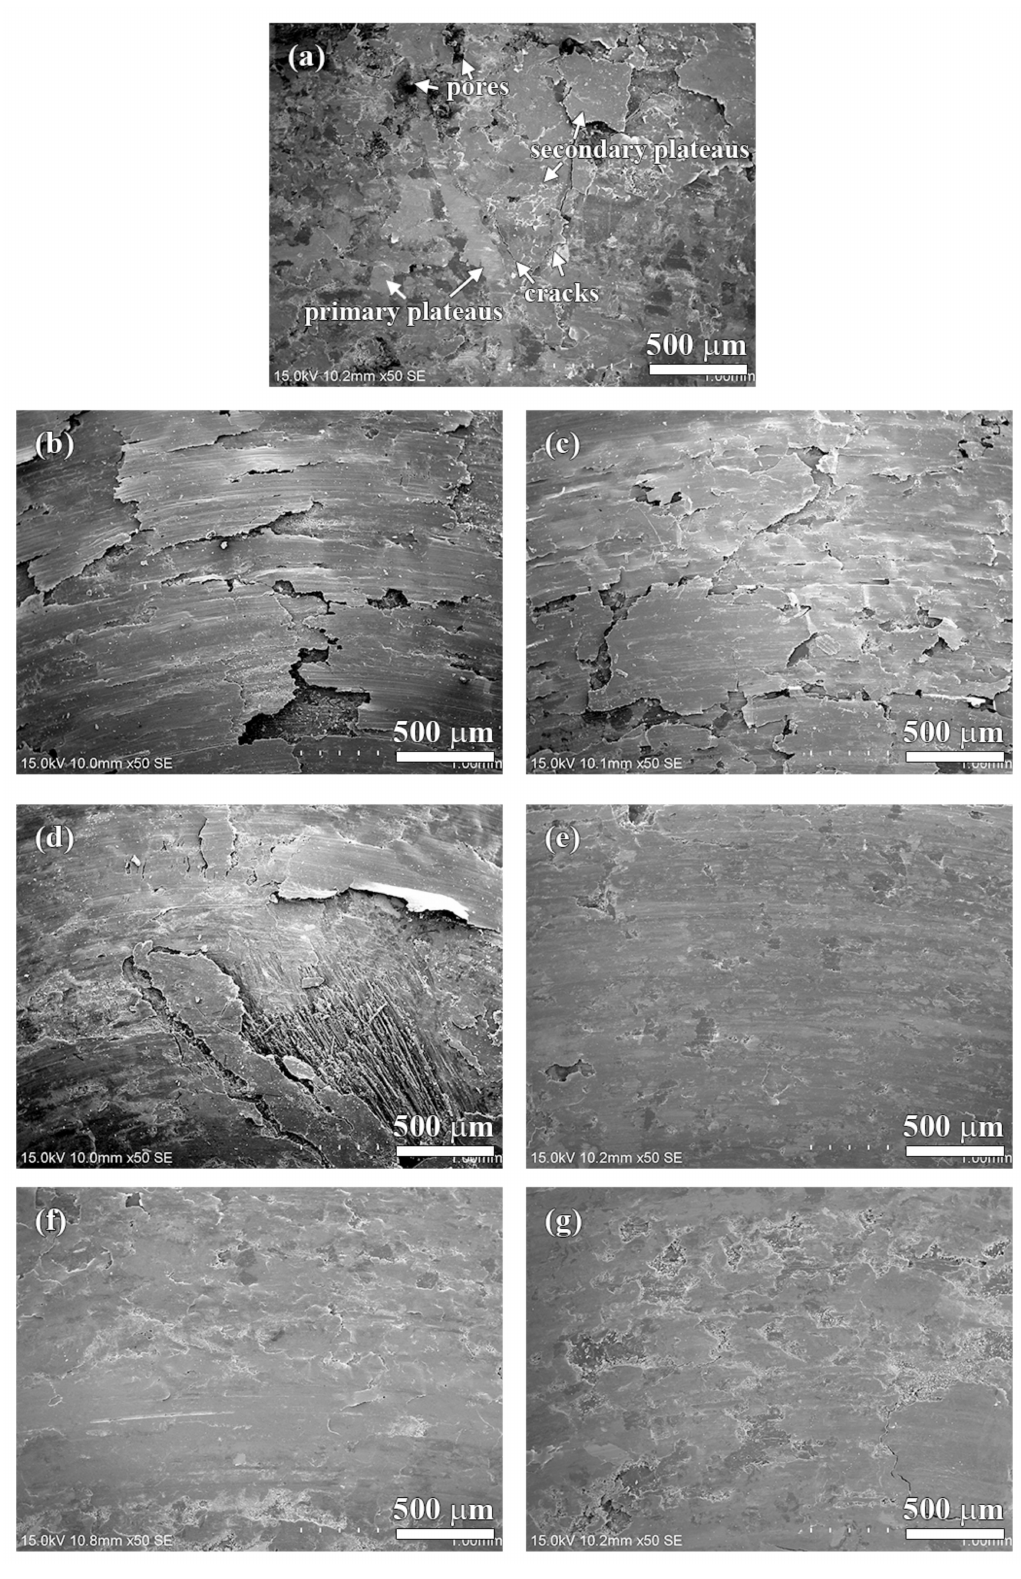
Figure 9. General worn surfaces of specimens: ( a ) NAO, ( b ) Coke, ( c ) CB, ( d ) CF, ( e ) AG, ( f ) NG; ( g )